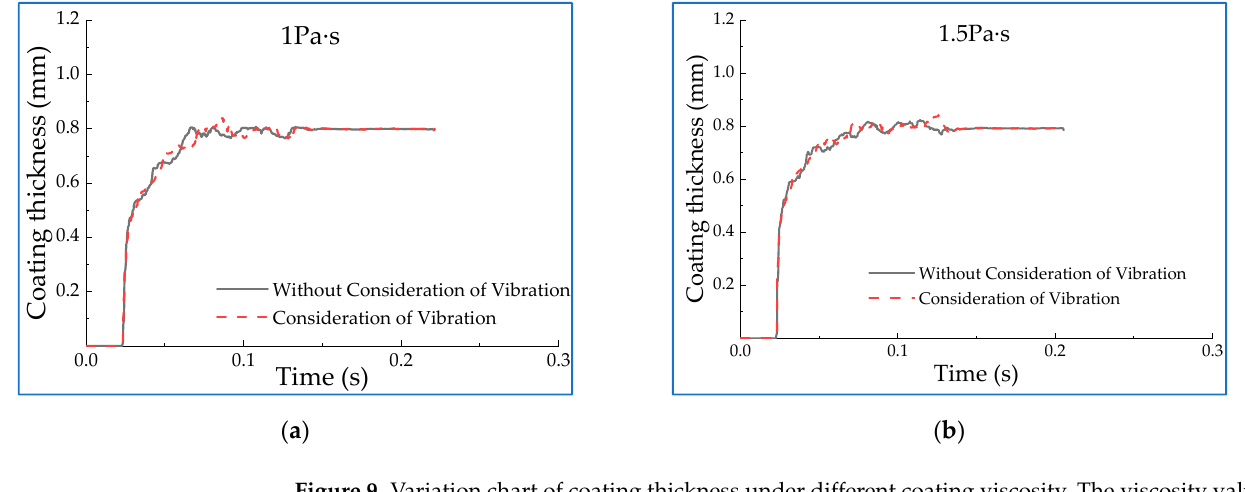
Figure 9. Variation chart of coating thickness under different coating viscosity. The viscosity values are ( a ) 1 Pa·s and ( b ) 1.5 Pa·s.